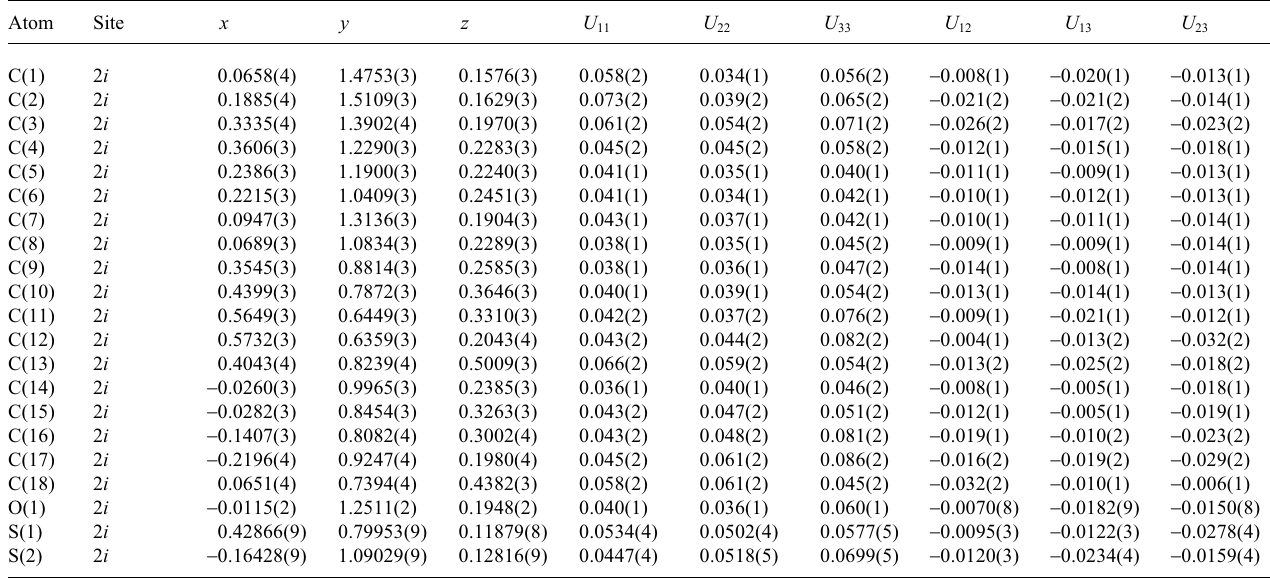
Table 3. Atomic coordinates and displacement parameters (in Å 2